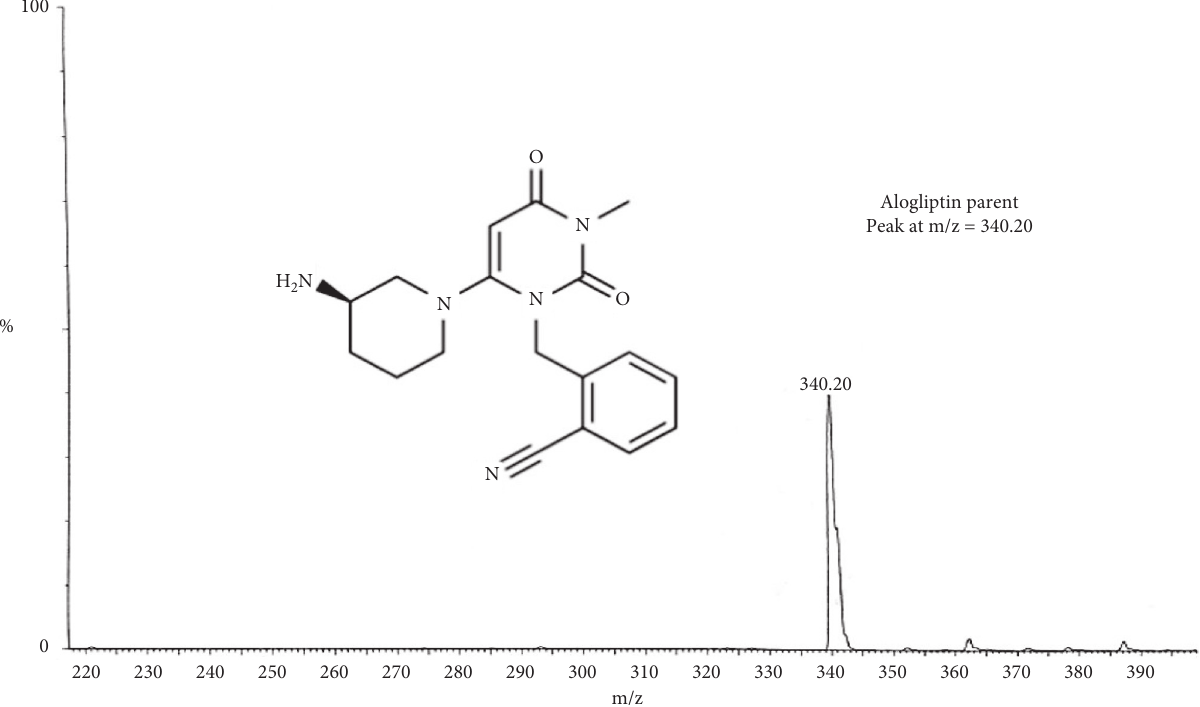
Figure 2: MS of IS and its chemical